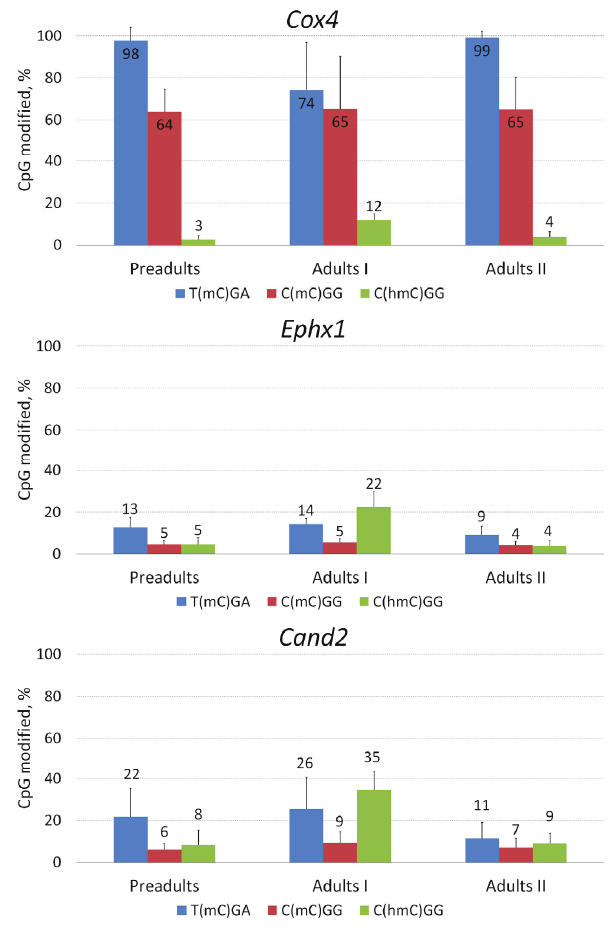
Figure 3. Percentage of CpG-modified sites in selected regions of three D. pulex genes— Cox4 , Ephx1 and Cand2 . Blue columns represent percentage of methylated CpG in TCGA sequences, red columns—percentage of methylated CpG in CCGG sequences, green columns—percentage of hydroxymethyated CpG in CCGG sequences. Error bars represent standard deviation.